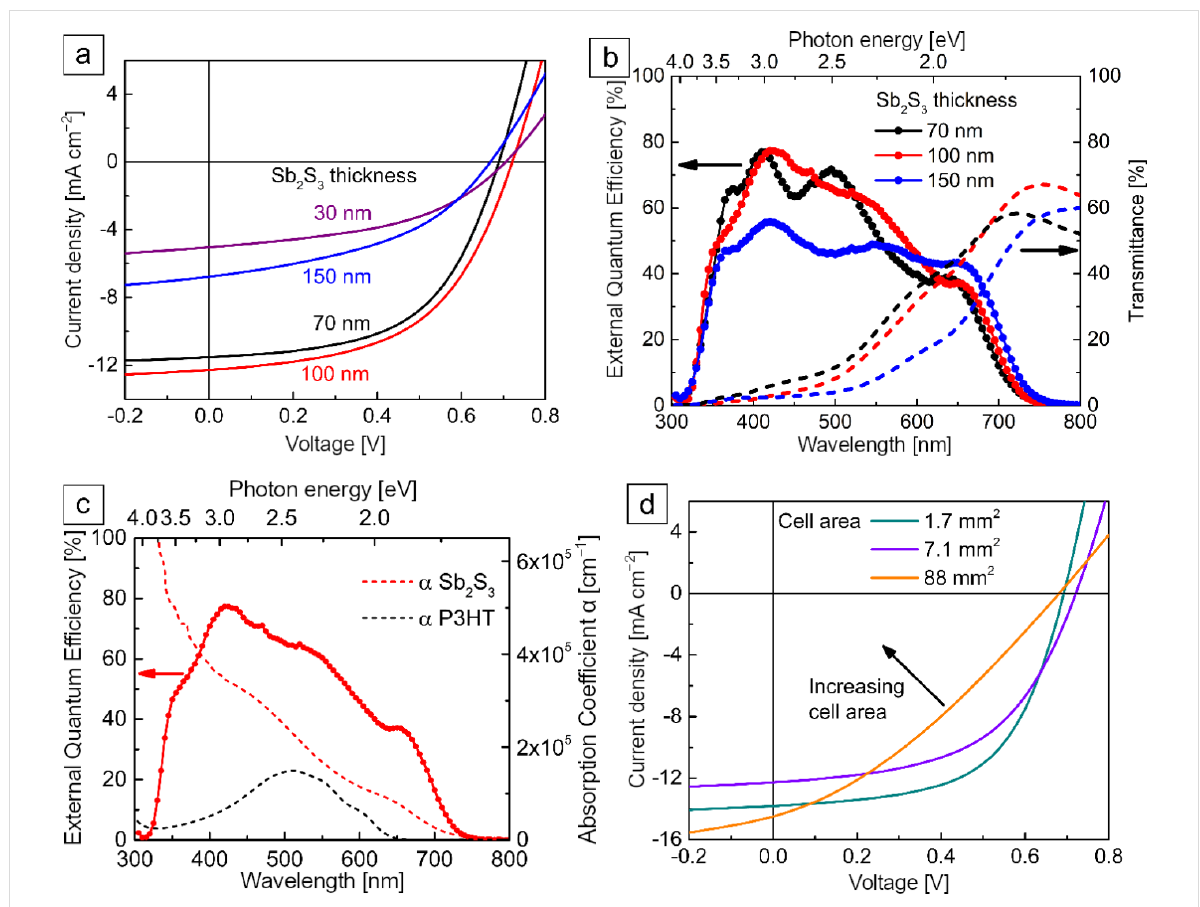
Figure 3: (a) Effect of Sb 2 S 3 absorber thickness on J–V curves at AM1.5G. (b) EQE of solar cells and transmittance of the glass/ITO/TiO 2 /Sb 2 S 3 stack. (c) EQE of the best-performing solar cell (100 nm Sb 2 S 3 ) and absorption coefficients ( α ) of Sb 2 S 3 and P3HT. (d) J–V curves at AM1.5G of 100 nm Sb 2 S 3 solar cells of different size.